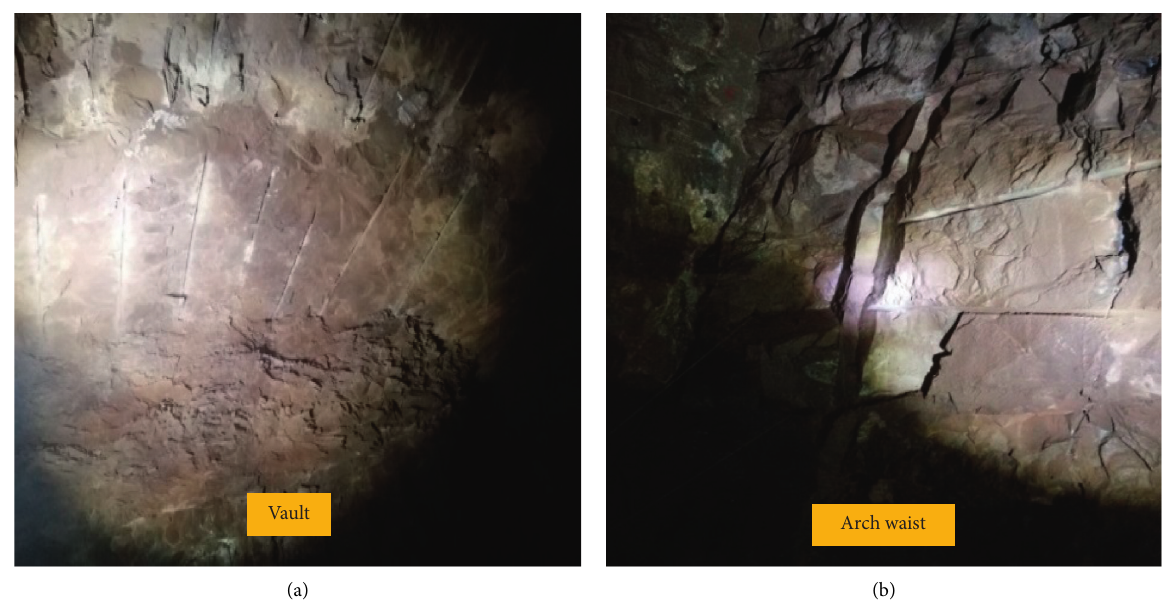
Figure 29: Field construction blasting effect. (a) Blasting effect of vault. (b) Blasting effect of arch